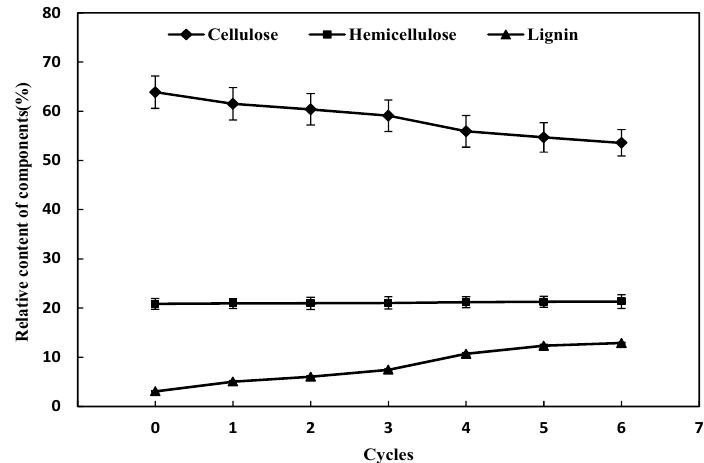
Figure 1. Effect of different times of alkaline black liquor circulation combined with ozone pretreatment on the content of three major components.